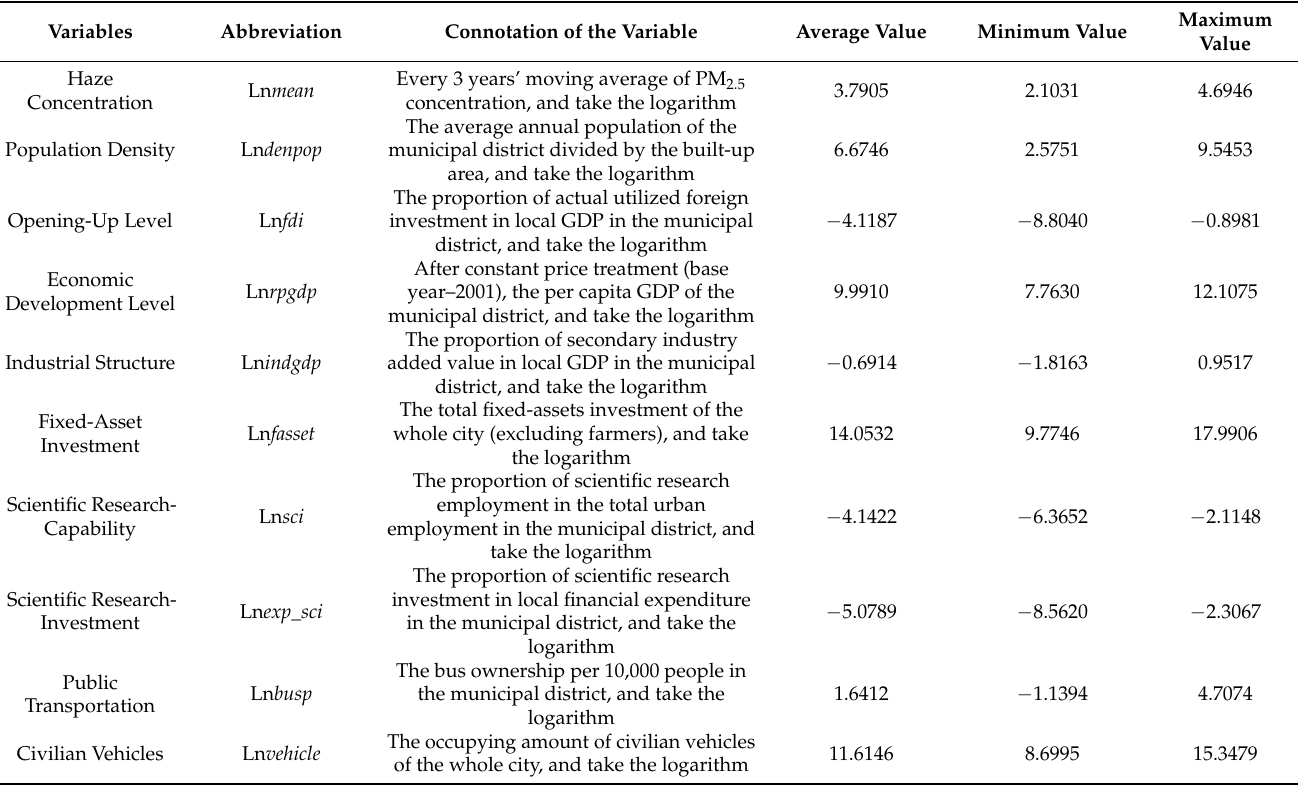
Table 1. Description of Primary